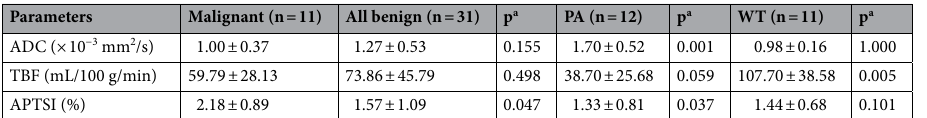
Table 2. Comparison of MR parameters between benign and malignant salivary gland lesions. ADC, apparent diffusion coefficient; TBF, tumor blood flow; APTSI, amide proton transfer related signal intensity; PA, pleomorphic adenoma; WT, Warthin tumor. a Comparisons with malignant lesions were assessed using the Mann–Whitney U